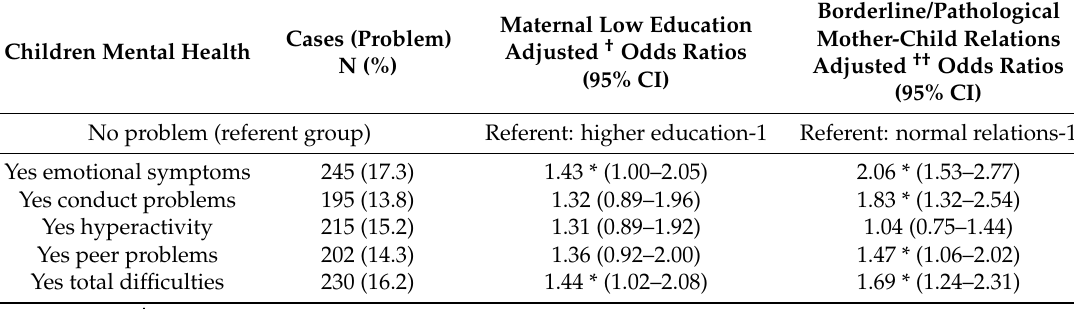
Table 3. Associations between low maternal education, borderline/pathological mother-child relations, and children’s mental health difficulties as adjusted odds ratios and their 95% confidence intervals